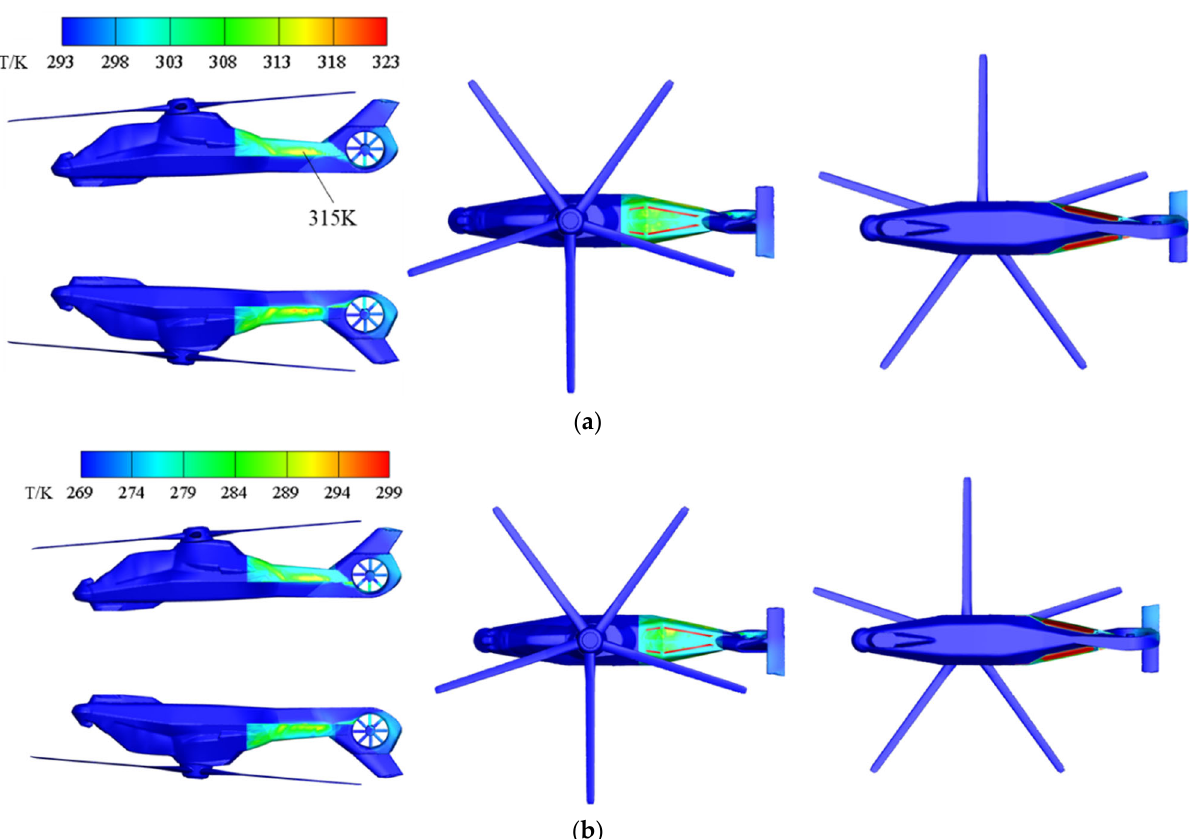
Figure 10. Temperature distribution of the fuselage surface. ( a ) Ambient temperature—293 K; and ( b ) ambient temperature—269 K.